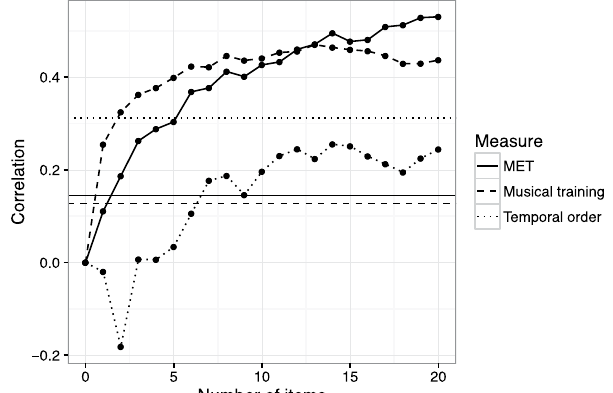
Figure 4. Pearson correlations with validity measures as a function of test length (test Version 1). The three horizontal lines indicate two-tailed thresholds of statistical significance at p < 0.05 for the respective validity measures.